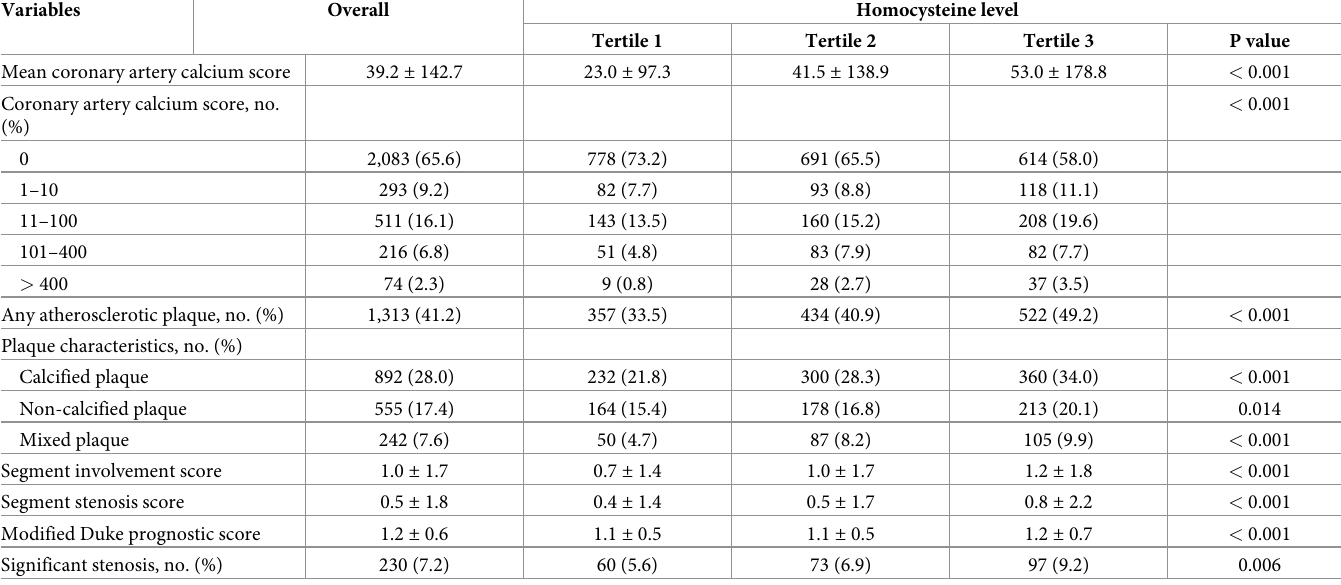
Table 2. Comparison of coronary computed tomography angiographic findings according to the tertiles of